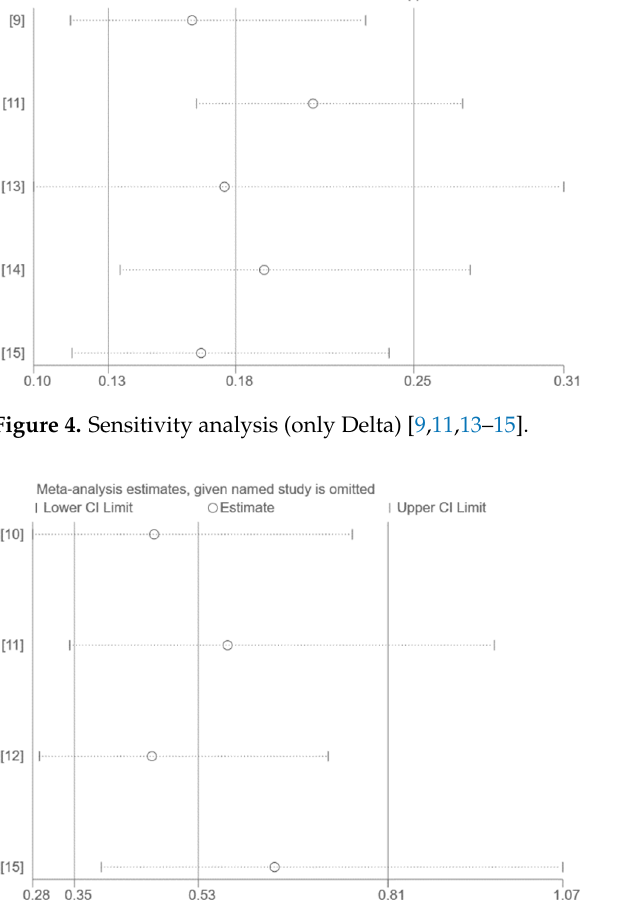
Figure 5. Sensitivity analysis (only Omicron) [10–12,15].